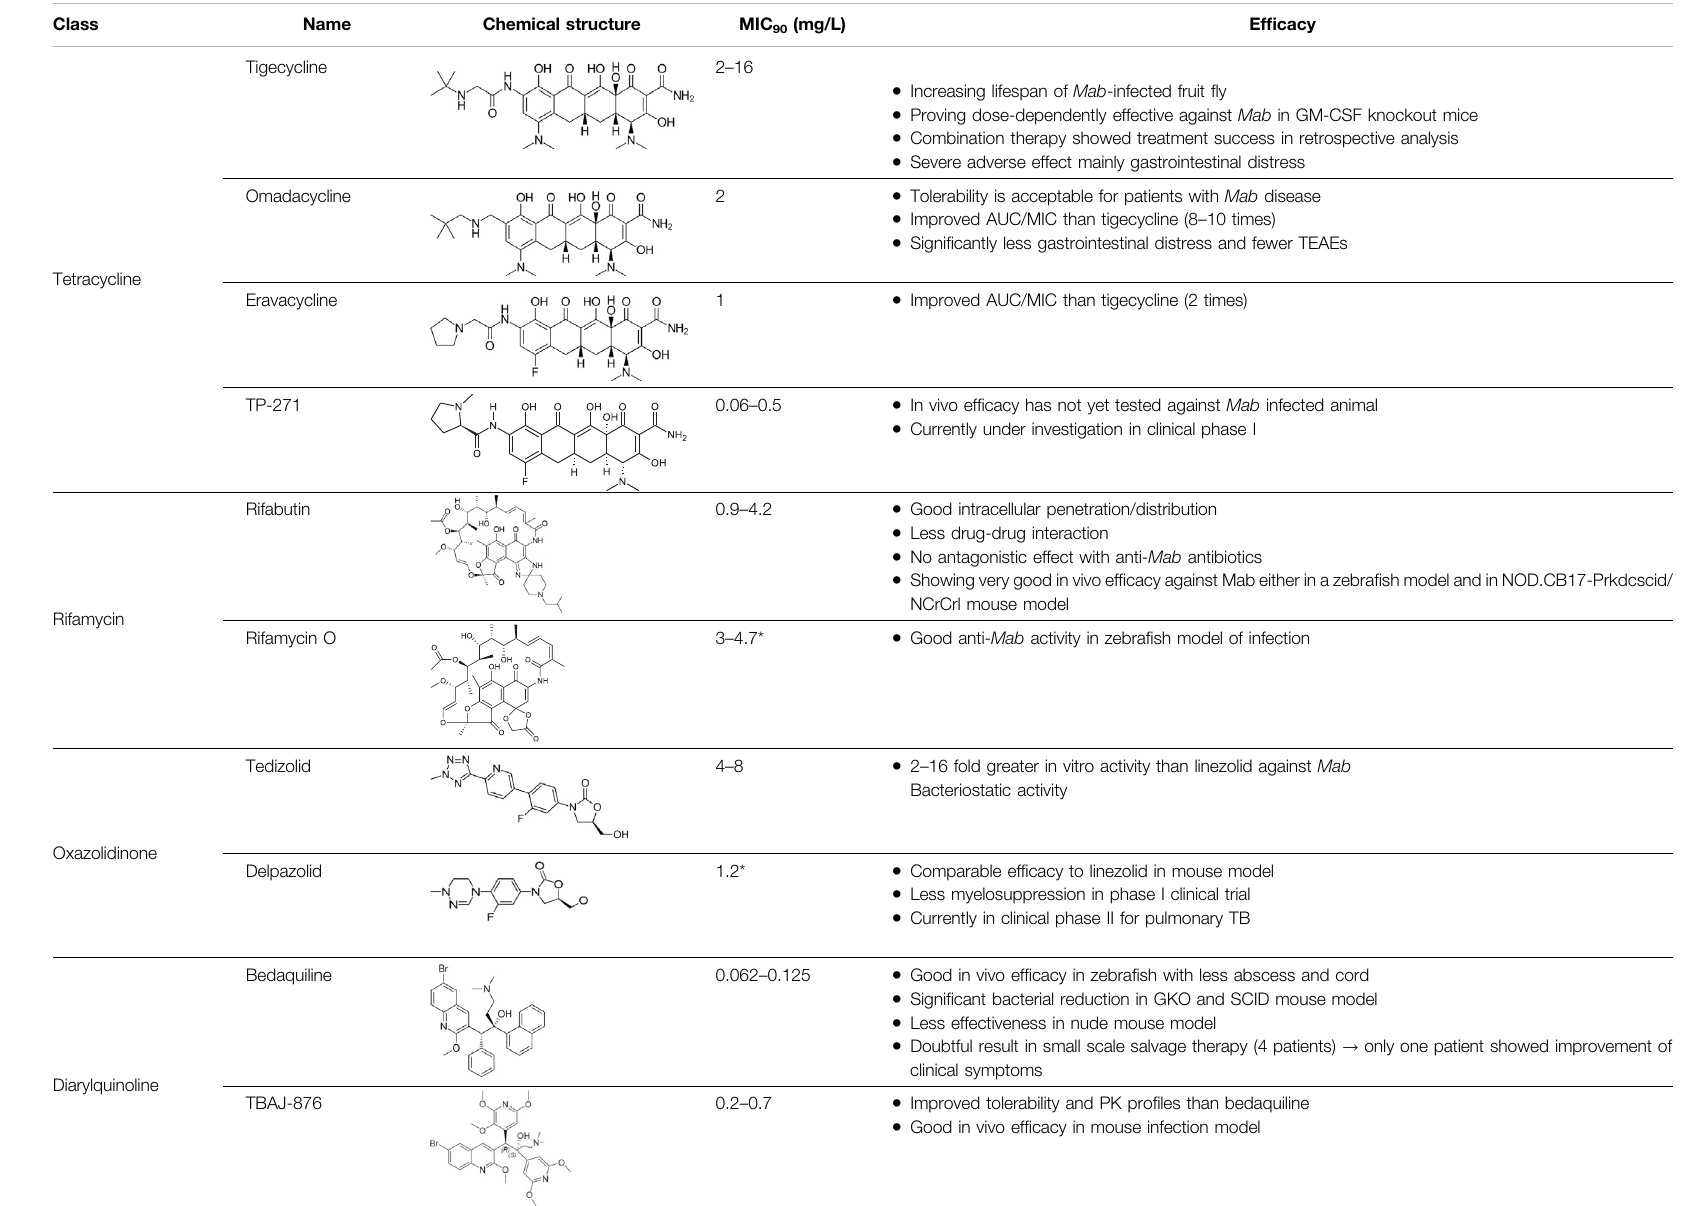
TABLE 2 | The current state of Mab antibiotics, with compounds currently going through development. * Indicates MIC 50